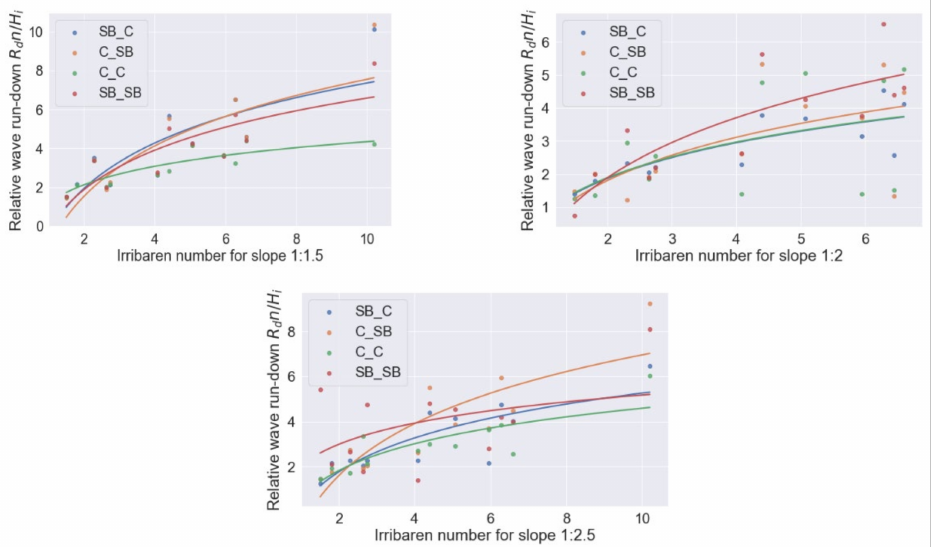
Figure 20. Relative wave R dn /Hi for the three